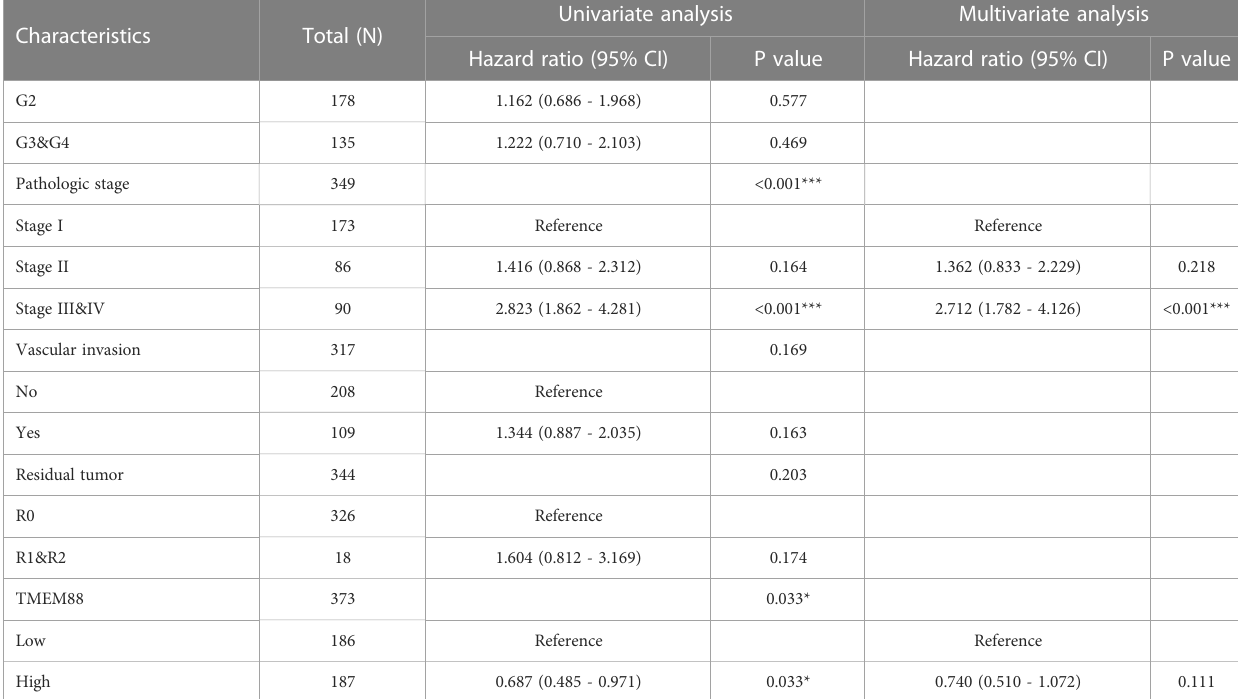
curve, we con fi rmed that overexpressing TMEM88 attenuated HCC growth (Figure 6B). Consistent with the growth curve, isolated xenografts established by TMEM88-overexpressing cells showed signi fi cant lighter tumor weight and smaller tumor size compared to those established by control cells (Figures 6C, D).